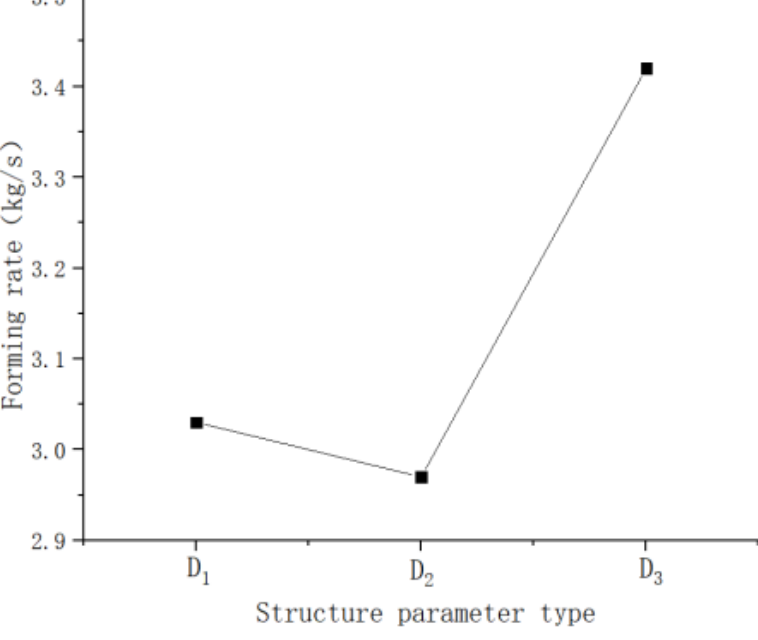
Figure 5. Forming rates of an underground irrigation composite pipe with three groups of different structural